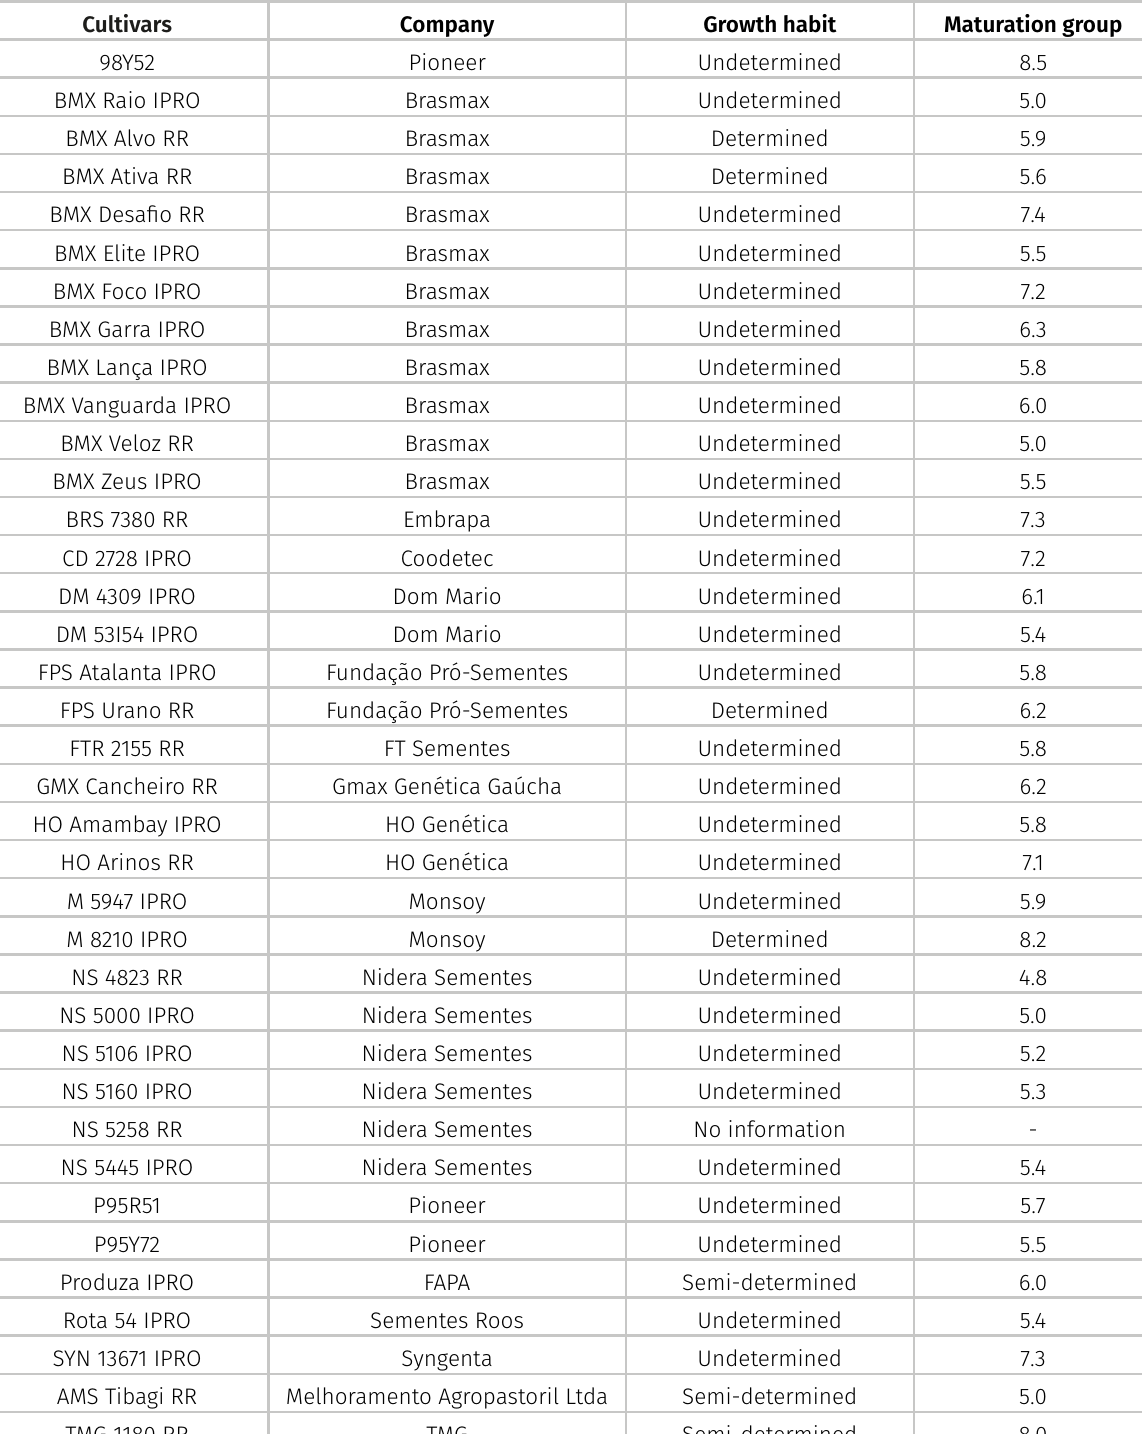
Table I. Description of commercial soybean genotypes with their respective agronomic characteristics.